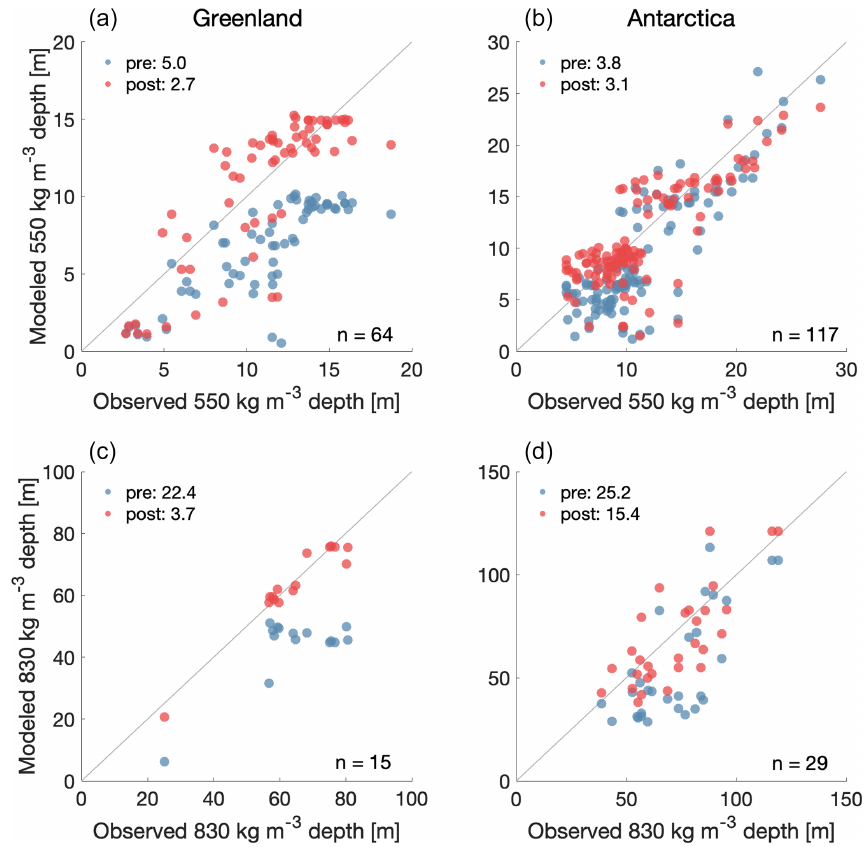
Figure 4. Comparison between modeled and observed 550kgm − 3 (a, b) and 830kgm − 3 (c, d) depths for the Greenland (a, c) and Antarc- tic (b, d) Ice Sheets for the locations of firn cores shown in Fig. 3. Blue markers show pre-calibrated model agreement with observations, and red markers show the post-calibrated model fit. The one-to-one line is shown by the black diagonal lines. Pre- and post-model calibration fits to observations (root mean square error: RMSE) are shown in the top left of each